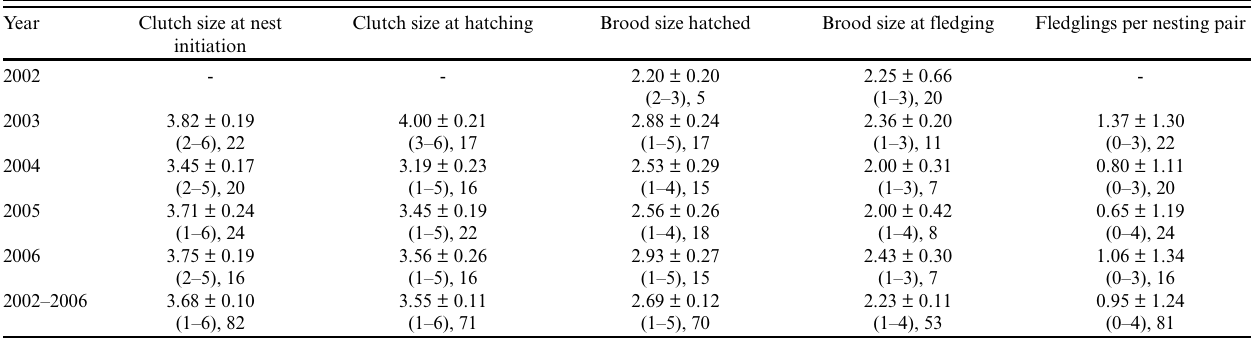
Table 1 . Annual and total values of reproductive parameters and productivity per nesting pair of Turquoise-fronted Parrot ( Amazona aestiva ) in the dry Chaco Forest, Argentina, 2002–2006. Values represent mean ± SD (range), n.